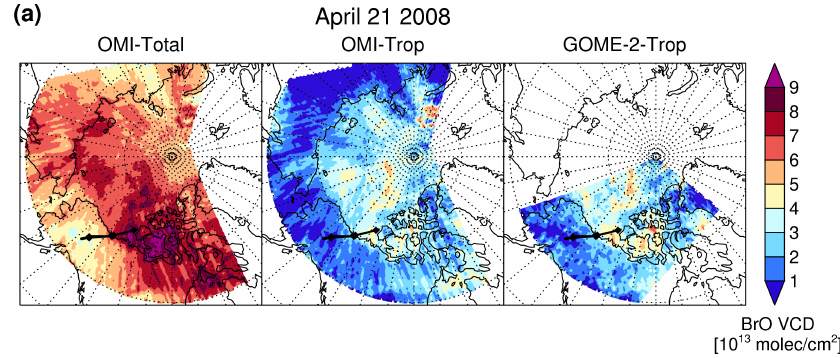
Fig. 10a. Similar to Fig. 7a but for the WP-3D flight of 21 April 2008.